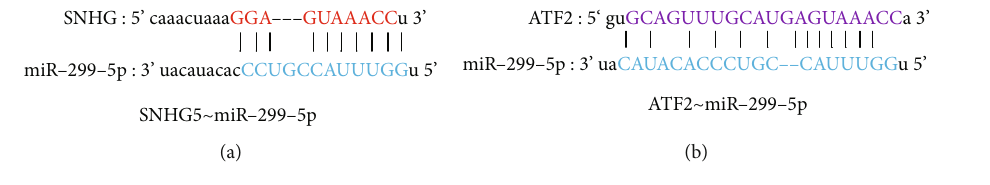
Figure 7: The binding site of genes. (a) The binding site of SNHG5/miR-299-5p. (b) The binding site of miR-299-5p/ATF2. fi broblast ( r = 0 : 961 , p < 0 : 01 ) but was negatively correlated with T cell CD8+ ( r = − 0 : 641 , p = 0 : 0456 ) and myeloid den- dritic cell ( r = − 0 : 939 , p < 0 : 01 ) (Figure 9(b)); SNHG5 was pos- itively correlated with neutrophil ( r = 0 : 725 , p = 0 : 0177 ), endothelial cell ( r = 0 : 759 , p = 0 : 0109 ), and cancer-associated fi broblast ( r = 0 : 782 , p < 0 : 01 ) but was negatively correlated with T cell ( r = − 0 : 815 , p < 0 : 01 ) (Figure 9(c)).